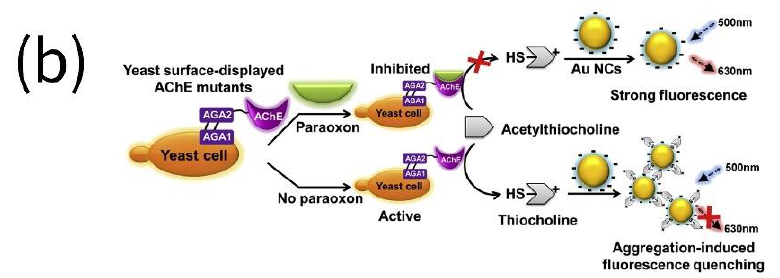
Figure 3. Assays for the detection of pesticide residues in food by nanozymes. ( a ) Five pesticides (i.e., lactofen, fluroxypyr-meptyl, bensulfuron-methyl, fomesafen and diafenthiuron) were detected using heteroatom-doped graphene sensor arrays (reprinted with permission from [51], Copyright 2020, American Chemical Society). ( b ) Paraoxon was detected using fluorescent AuNCs (reprinted with permission from [50], Copyright 2020, Elsevier).